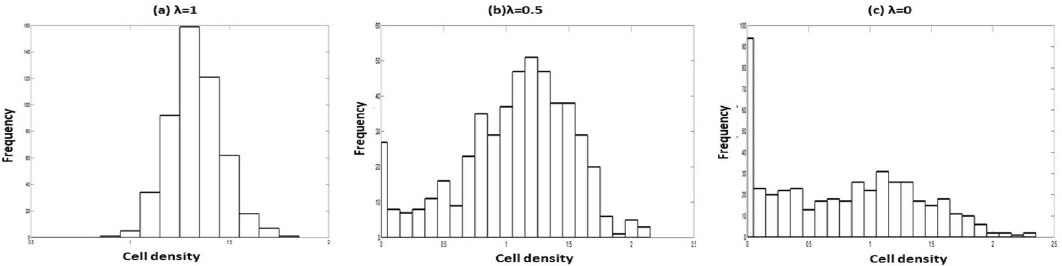
0.13 , K 1.43 , n 0.0095 , α = = =